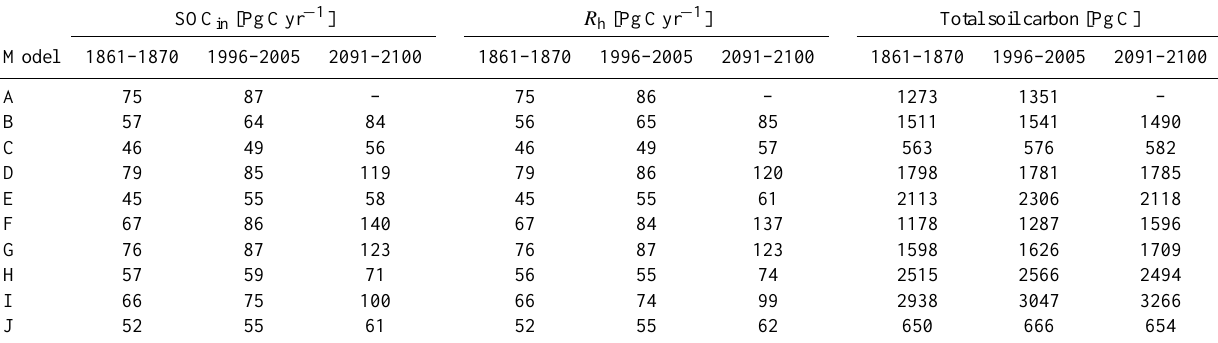
Table 3. Model specific values of SOC in , R h and SOC used in Figs. 1 to 4. Values are averaged over the indicated years. All data are rounded to whole numbers. Values for 2091–2100 are from the Representative Concentration Pathway 8.5 (RCP 8.5)